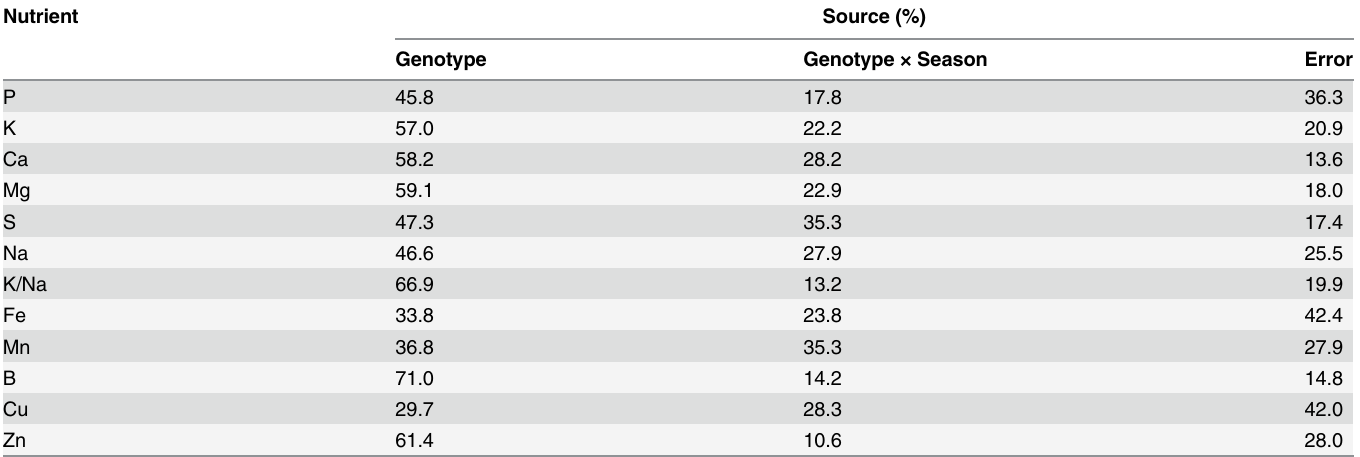
Table 2. Importance of variation source for five macro-, five micro-nutrient and Na concentrations and K/Na ratio on leaves revealed from a com- bined data analysis over two seasons. Nutrient Source (%)